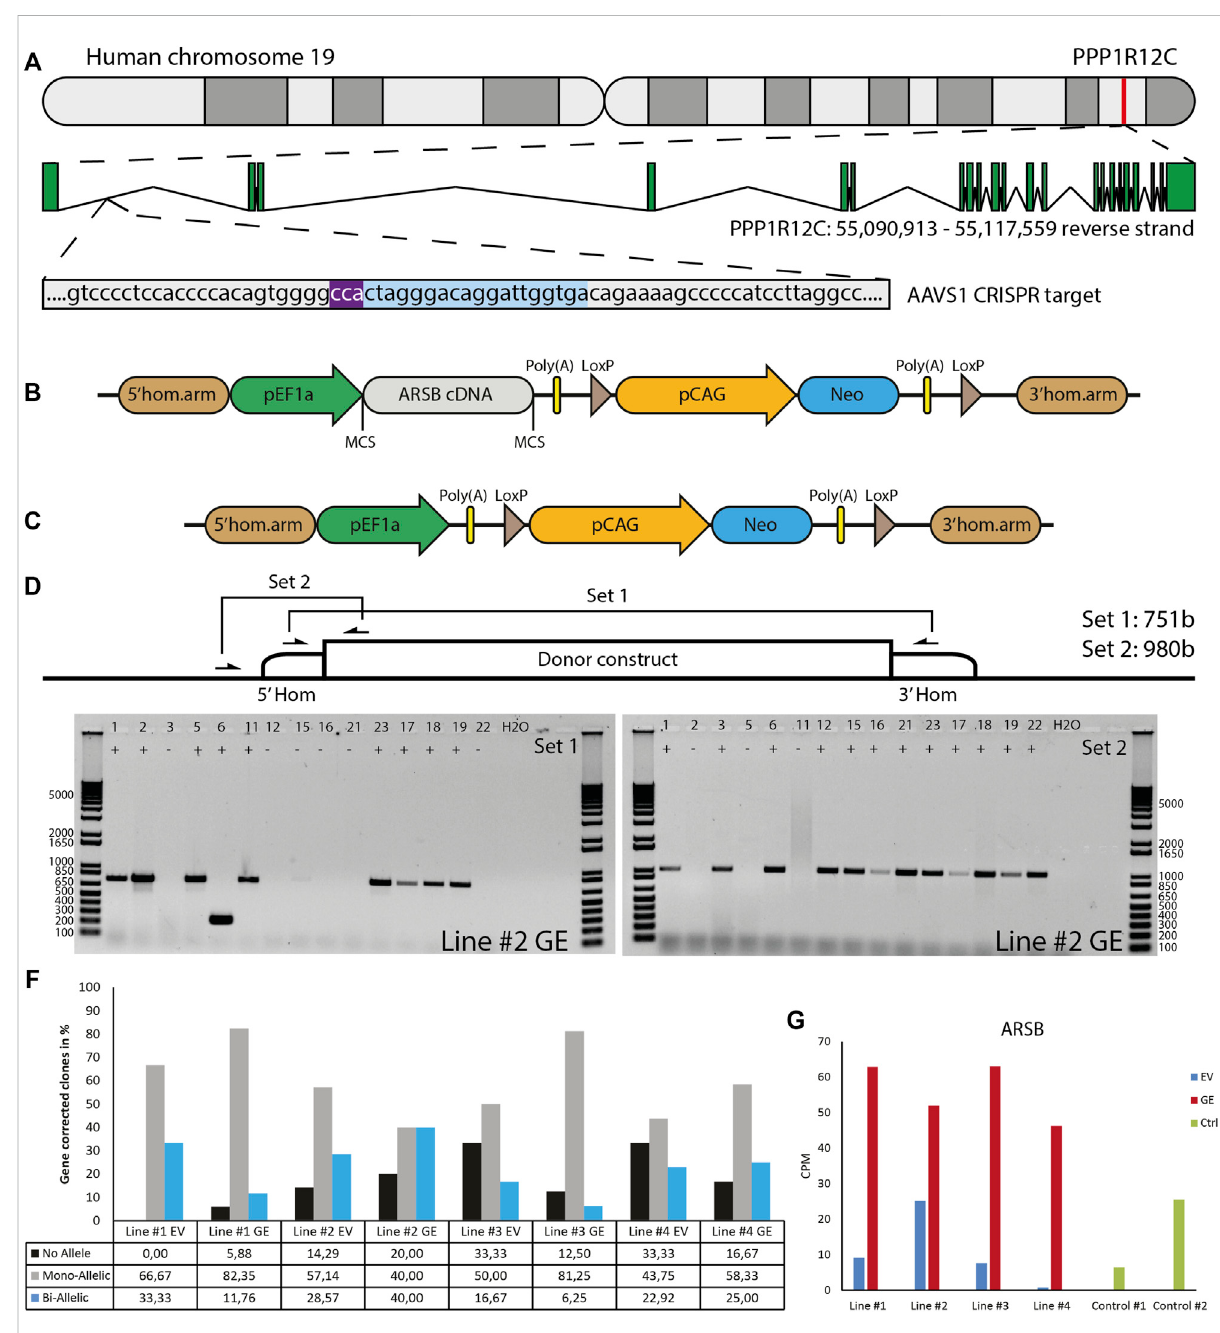
FIGURE 2 Gene editing in hiPSCs. (A) The gene editing strategy was designed to express ARSB from the AAVS1 locus. PAM sequence indicated in purple, gRNAtargetindicatedinblue. (B) ThedonorconstructgeneratedforinsertionoftheARSBcDNAintheAAVS1safeharborbyCRISPR/Cas9-mediated gene editing. The neomycin cassette enables G418 selection of targeted colonies. (C) The empty vector construct used to generate isogenic controls. (D) Strategy for the PCR based genotyping of targeted colonies, primer set 1 spans the insertion site and only gives a product in the absence of targeting, primer set 2 ampli fi es a product only in the presence of the construct at the target site. (E) Typical genotyping result of picked colonies.With primerset2, 12/15 colonies show successful mono-allelic or bi-allelictargeting. With primer set1,6/15lack aPCRproduct, indicating alossof theendogenous sequence. In combinationcolonies 3, 12,15, 16, 21 and 22 show bi-allelic insertion of theconstruct. DNA Ladder: 1 Kb Plus DNA Ladder (Invitrogen) (F) Quanti fi cation of mono-allelic, bi-allelic and unsuccessfully targeted colonies. (G) ARSB mRNA expression in the selected bi-allelic targeted clones, determined using RNAseq. GE: Gene edited with ARSB cDNA, EV: Gene edited with empty vector